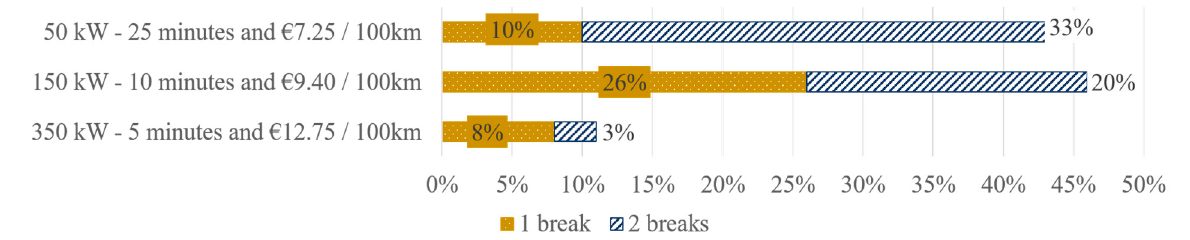
Figure 8. Preferences for range increase ( n = 2977; own diagram based on [8]).